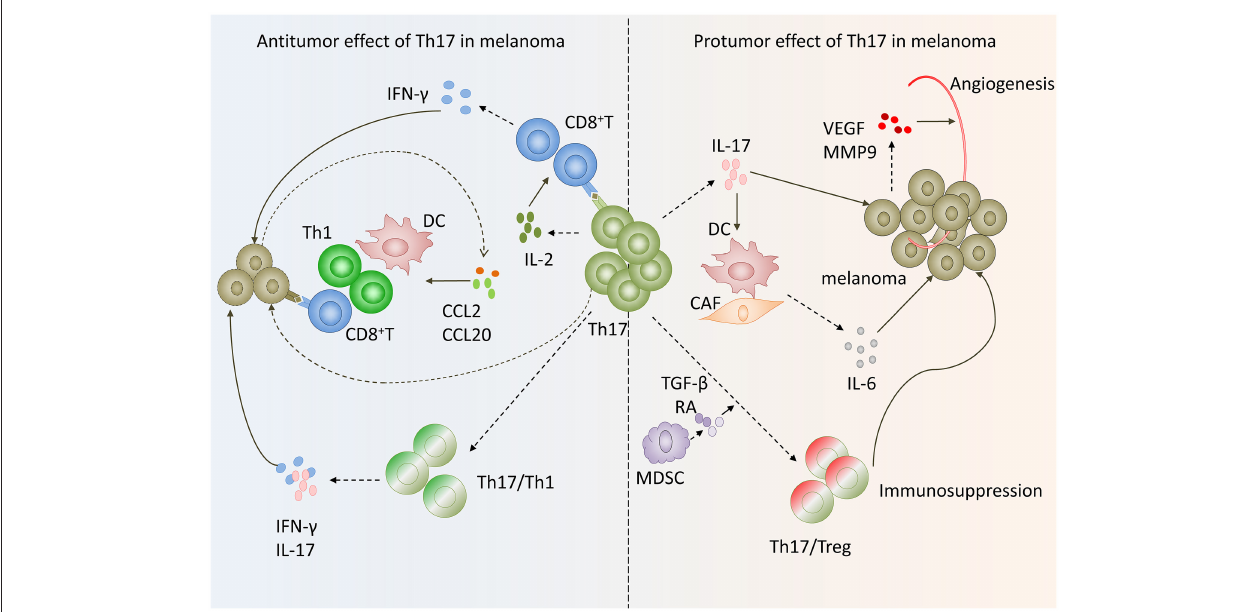
FIGURE 2 | Paradox of Th17 cells functions in melanoma. On the one hand, Th17 cells in melanoma exert antitumoral function via inducing effector cells recruitment and activating tumor-specific cytotoxic CD8 + T cells as well as transform to Th1 phenotype. On the other hand, Th17 cells exhibit protumor function by promoting angiogenesis, melanoma cells proliferation and phenotype change toward